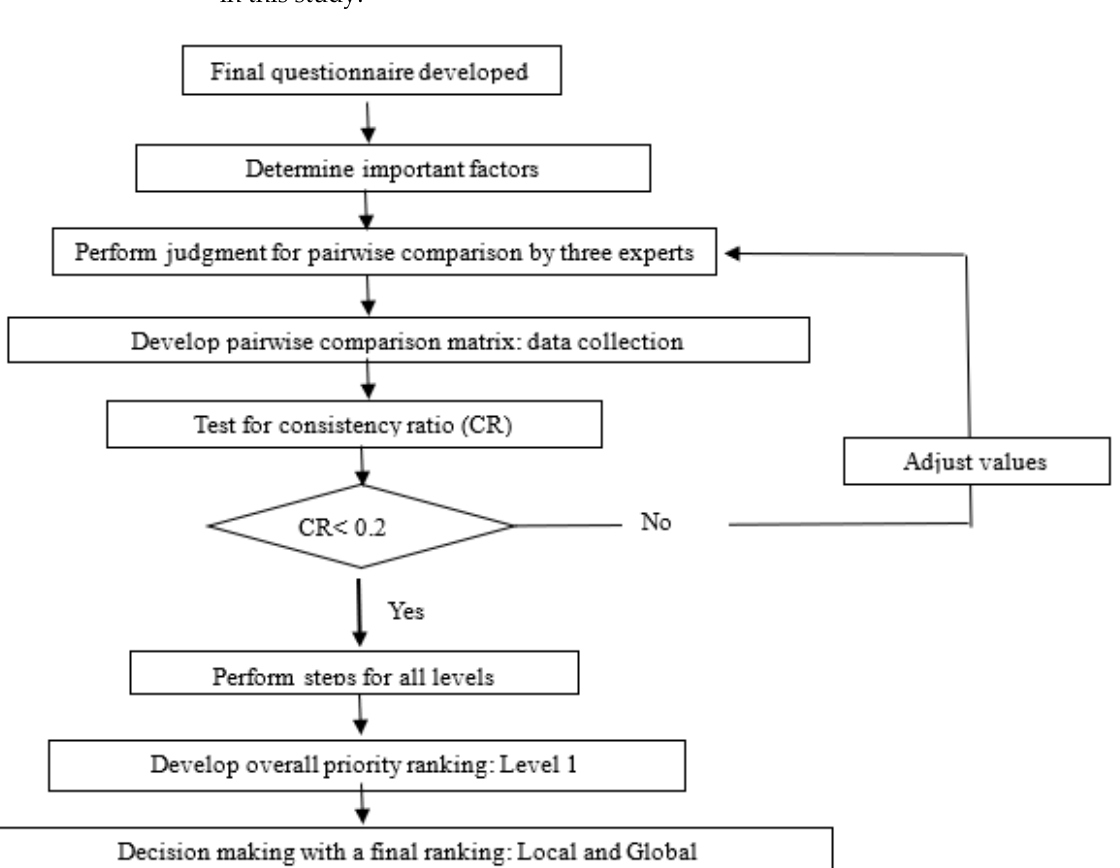
Figure 1. The analytic hierarchy process framework.